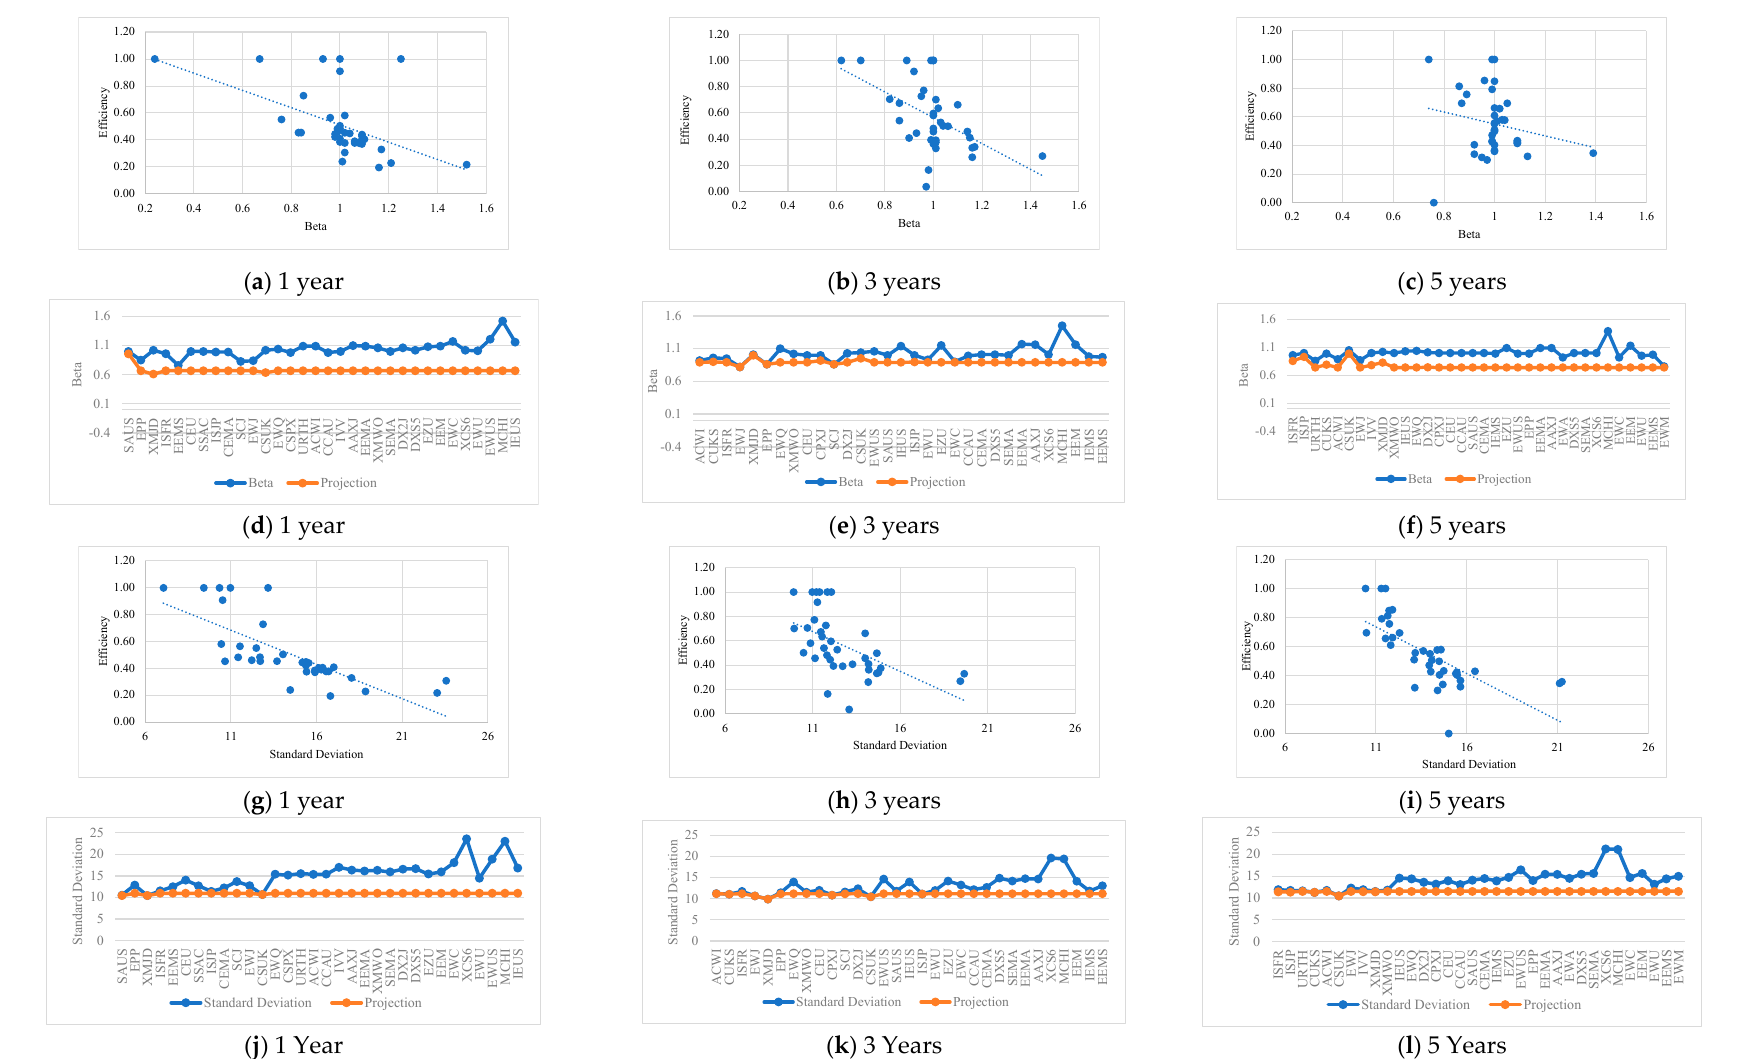
Figure 1. Efficiency scores vs. inputs and projections (ETFs are ordered in decreasing order of efficiency) for the different time